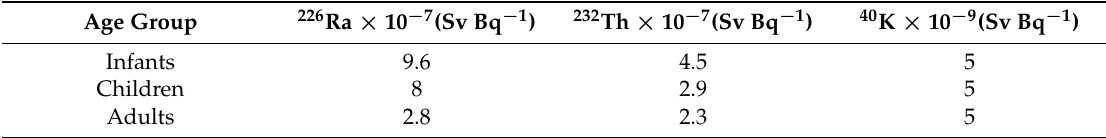
Table 1. The conversion factors ( C F (W) ) of the relevant radionuclides for different age groups